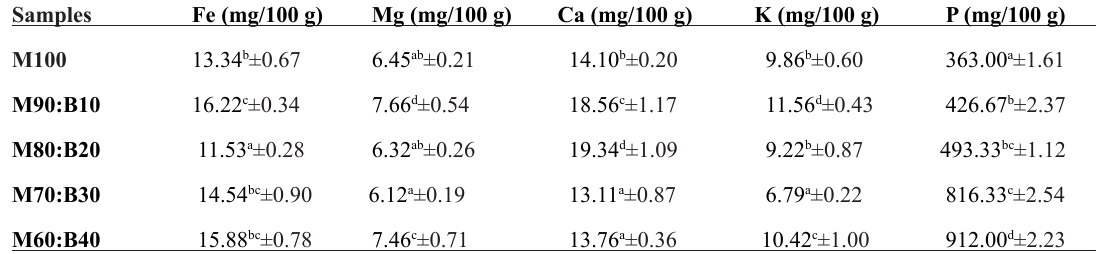
Table 3: Mineral Composition of Maize-Bambara nut Composite Flours.